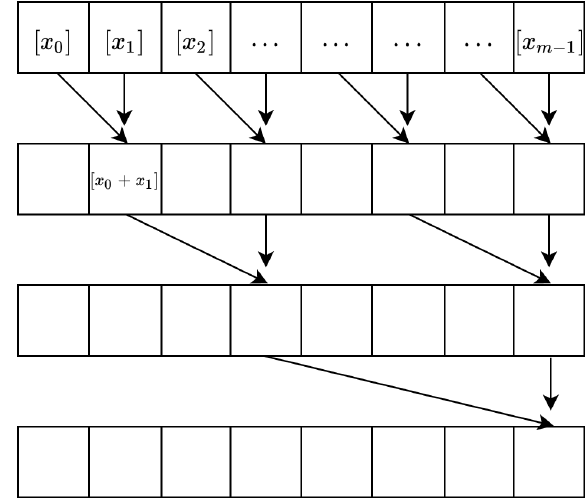
Figure 6. P ARALLEL -P REFIX -S UM algorithm data flow.